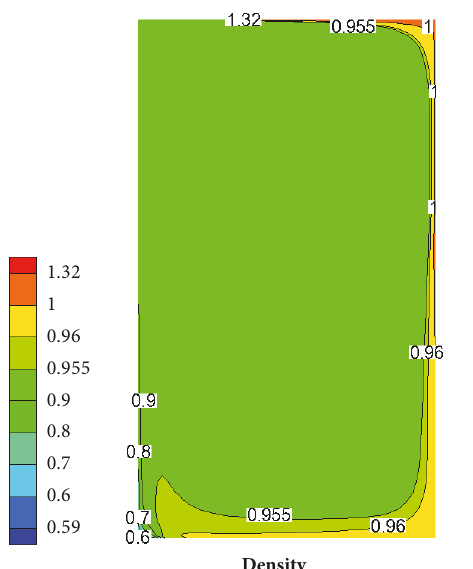
Figure 8: Gas mixture density in the scaled AP600 containment.